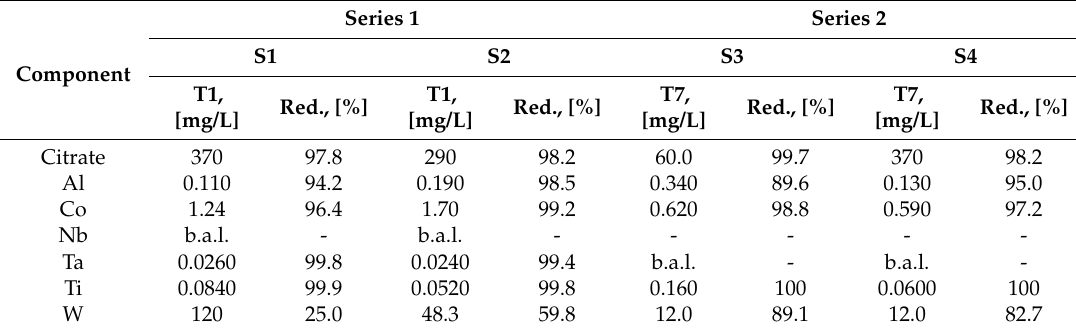
Figure 6. Concentration of the citrates in the initial solutions (start, continuous line) and the filtrates of series 1 ( a , T1 – T6) and series 2 ( b , T7 – T12) [3]. Table 3. Concentrations of the citrates and different metal ions of the treated solutions S1, S2, S3, and S4 after the first tests (T1 and T7, respectively) of series 1 and 2 (b.a.l., below the analytical limit of determination) measured by IC and ICP-MS and the reduction (Red.) in percentage with respect to the initial values given in Table 1 [3].